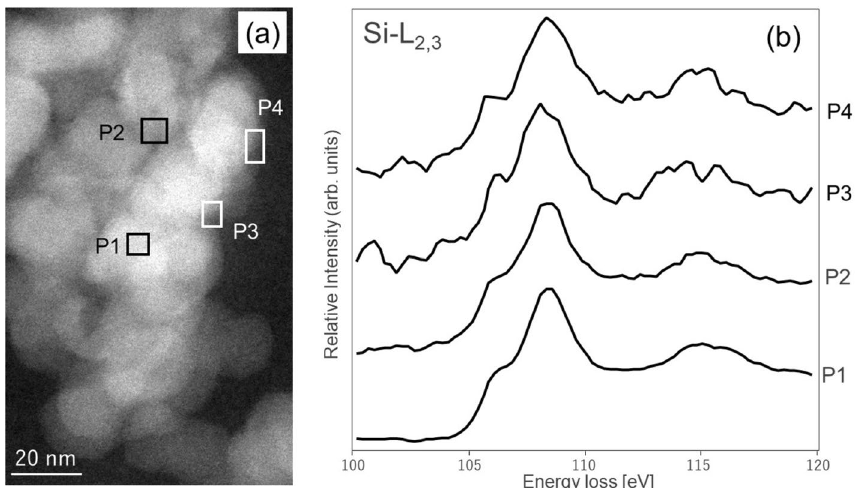
Figure 2. Si-L 2,3 edge obtained from the SBR composite containing 0 vol % SCA. (a) ADF-STEM image and (b) Si-L 2,3 edge EELS spectra. Rectangles P1–P4 in (a) indicate the areas from which the spectra in (b) were taken. Spectra P1 and P2 are obtained from the silica nanoparticle aggregates. Spectra P3 and P4 are obtained from the particle edges.